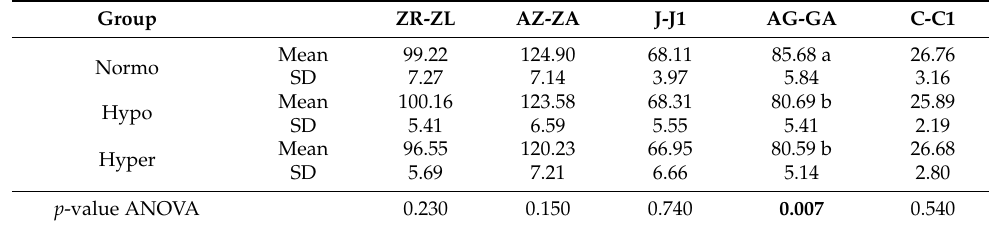
Table 4. Asymmetry horizontal variables, reported as means (mm) and Standard Deviations (SD) in the three study groups (Normo: Normodivergent; Hypo: Hypodivergent; Hyper: Hyperdivergent). Statistically significant p -values are reported in bold. Different letters indicate statistically significant difference between groups in the Tukey Post Hoc Test.